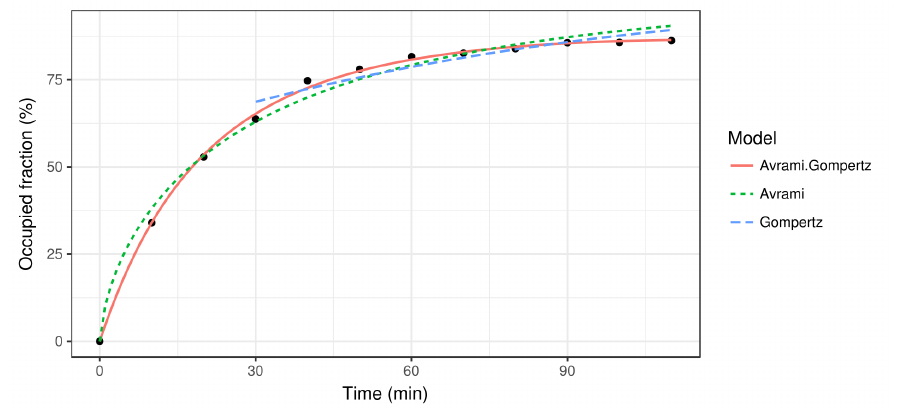
Figure 3. Estimation of the occupied fraction at different time stamps, from t = 0 to t = 120 min (black dots) together with the three different kinetic growth models: Avrami, Gompertz, and